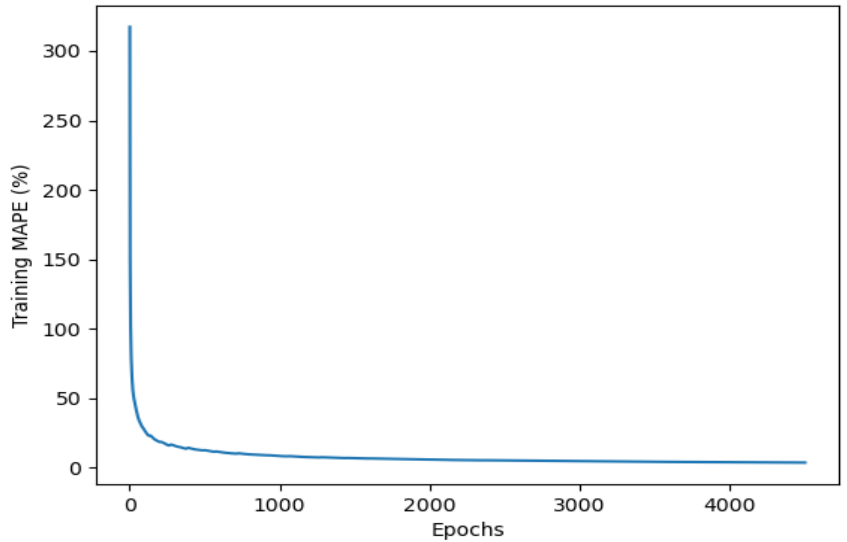
Figure 15. Final training MAPE of unimodal deep learning model.